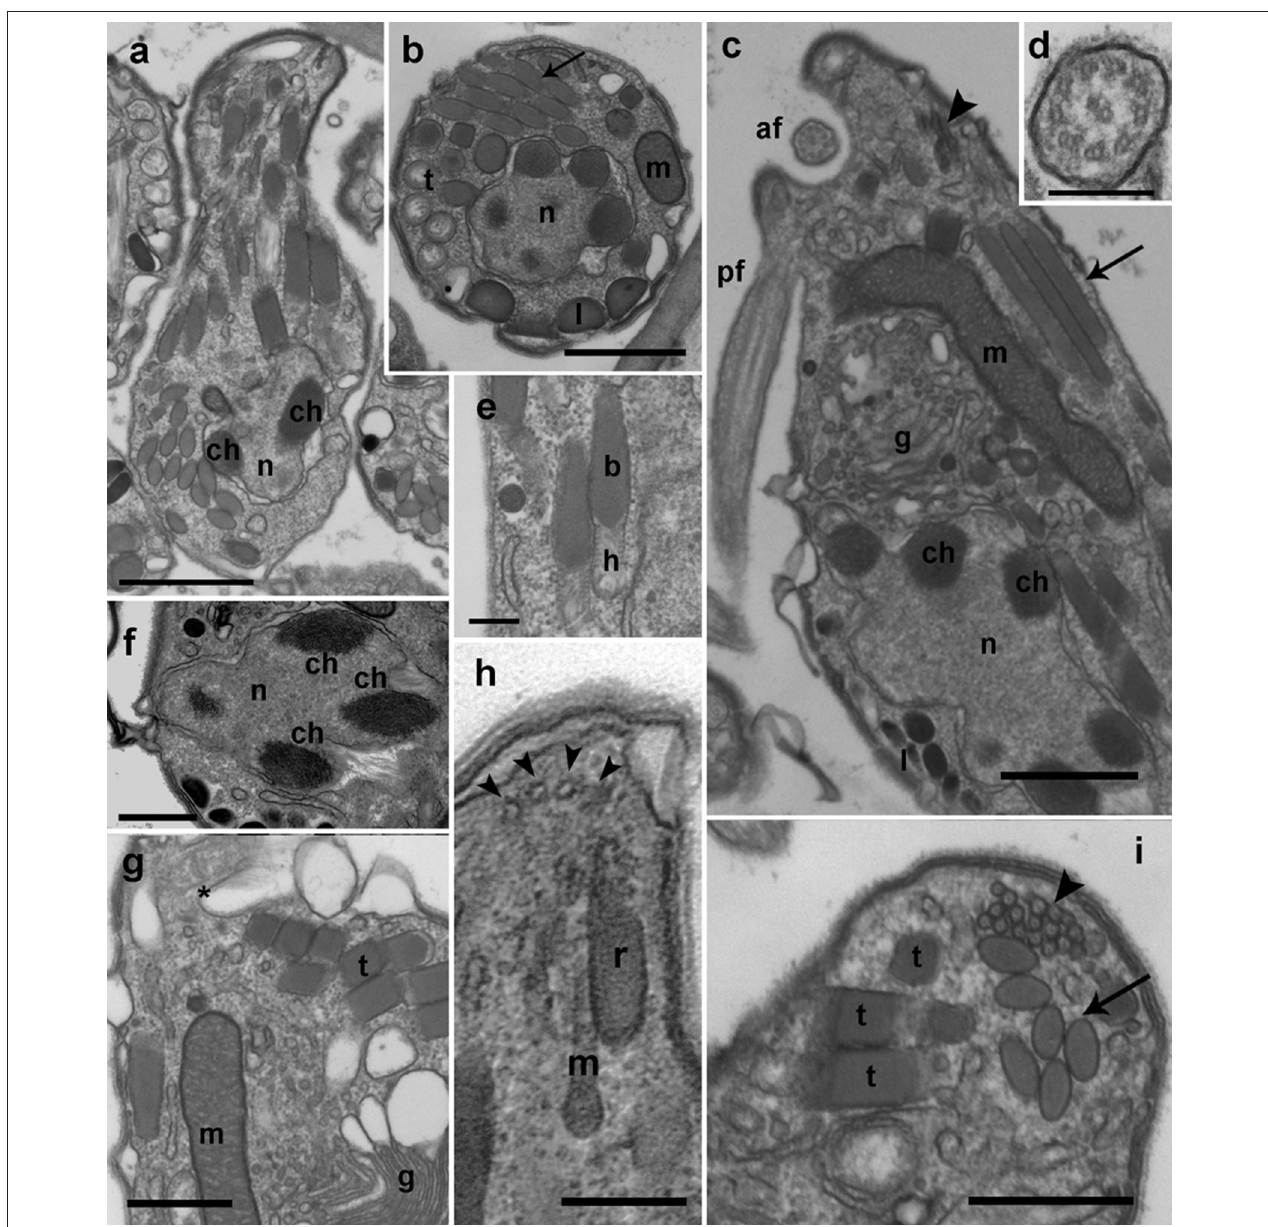
FIGURE 5 | TEM micrographs showing the general features of Dinovorax pyriformis zoospores. (a) Longitudinal section of a zoospore. The nucleus (n) contains heterochromatin as ovoid bodies (ch). (b) Transverse section of a zoospore. The nucleus (n) with heterochromatin occupies a central position, and mitochondrion (m), trichocysts (t), lipid droplets (l), and rhoptries (arrow) are located in the periphery. (c) Longitudinal section of a zoospore. The insertion area of the posterior flagellum (pf) and the anterior flagellum (af) are seen. A cluster of micronemes (arrowhead) and rhoptries running longitudinally (arrow) are visible. (d) Transverse section of the anterior flagellum axoneme showing a heteromorphic pair of central microtubules. (e) Detail of two bipartite trichocysts showing the body (b) and the head (h). (f) Detail of the nucleus (n) of a zoospore, showing three heterochromatin ovoid bodies (ch). (g) Section of a zoospore showing the Golgi body (g) and the basal body of anterior flagellum (*). (h) Oblique section of the apical area of a zoospore showing the pseudo-conoid microtubules (arrowheads), a microneme with bulbous end (m) and a rhoptry (r). (i) Section of the apical area of a zoospore, showing several trichocysts (t), rhoptries (arrow), and micronemes (arrowhead). Scale bars: (a,c) = 1 µ m; (b,f,g,i) = 500nm; (d,e,h) =